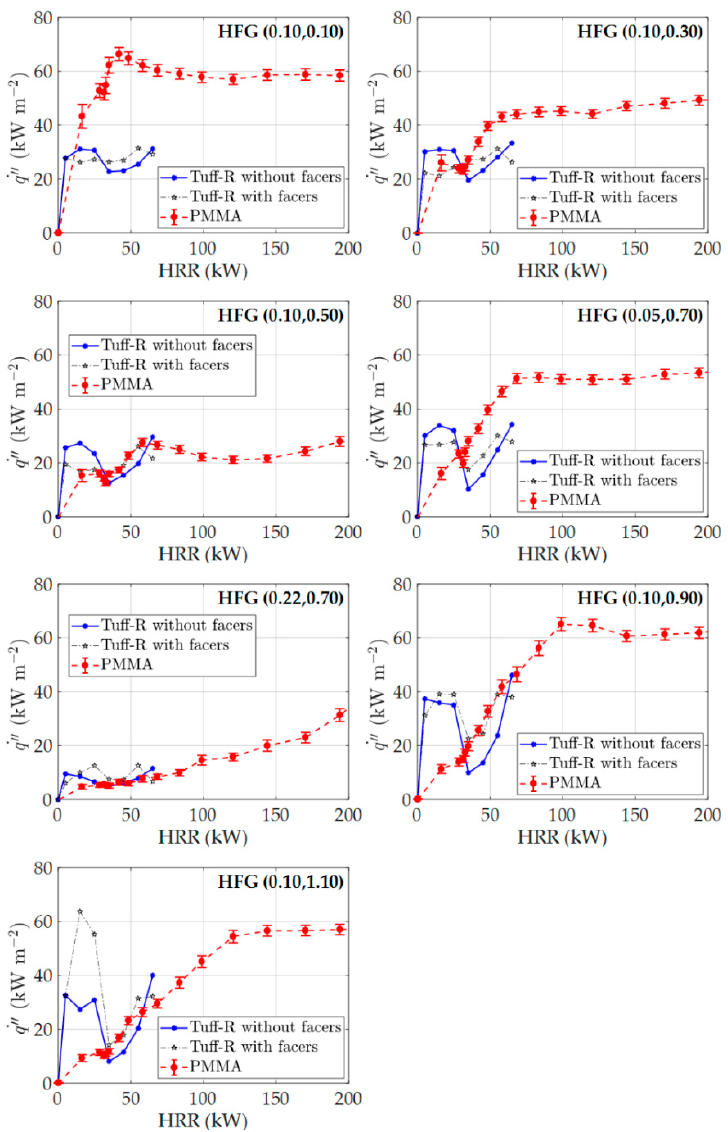
Figure 8. Flame heat flux dependencies on heat release rate measured with water-cooled heat flux gauges in the vertical corner flame spread experiments on the Tuff-R insulation panels and on PMMA [32].